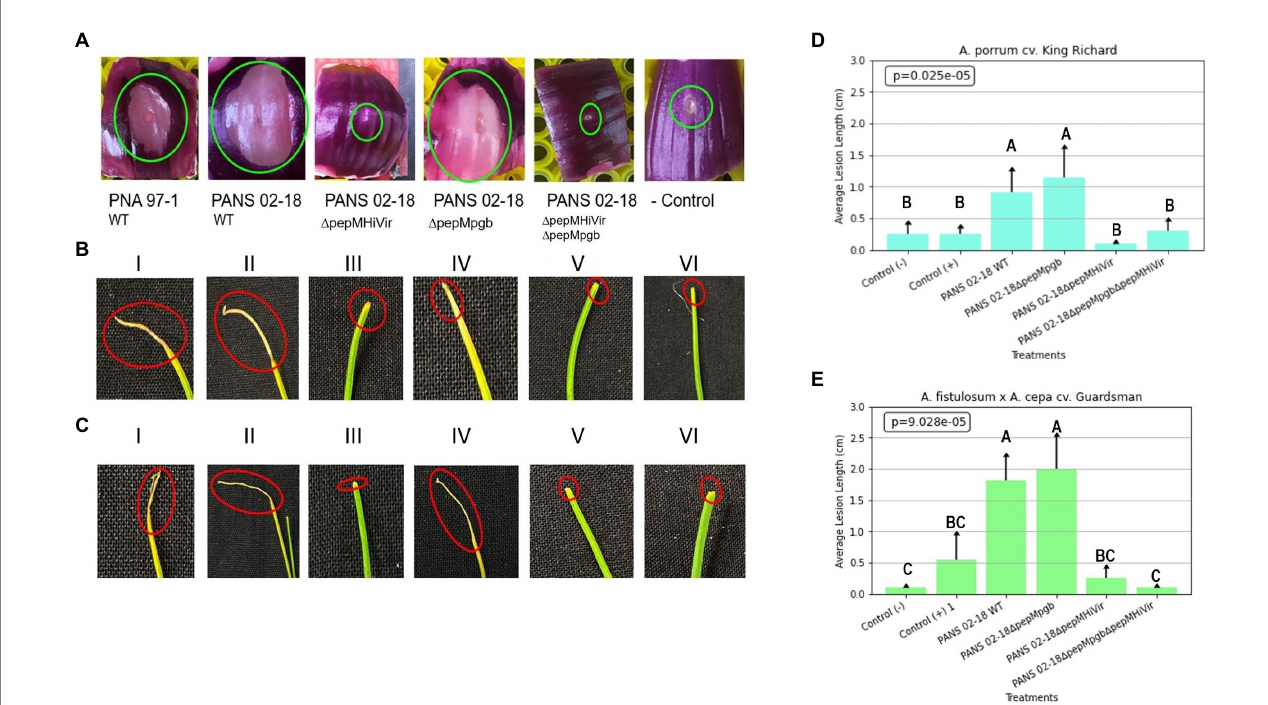
FIGURE 9 Role of HiVir and pgb biosynthetic clusters in foliar pathogenicity of Pantoea ananatis on Allium species. Panel (A) : Red scale necrosis phenotype observed with the wild-type and mutant strains of P. ananatis ; panel (B) : Foliar pathogenicity assay on leek ( Allium porrum cv. King Richard) seedlings with the wild- type and mutant strains of P. ananatis ; and (C) Foliar pathogenicity assay on Japanese bunching onion ( A. fistulosum × A. cepa cv. Guardsman) seedlings with the wild-type and mutant strains of P. ananatis . Green and red circles indicate red scale necrosis and foliar necrosis, respectively. Panels (D) and (E) display the results of the mean lesion length with standard error in A. porrum and A. fistulosum × A. cepa upon inoculation with the wild-type and mutant strains of P. ananatis . The strains utilized in the experiments mentioned above include positive control strain PNA 97-1, positive control PANS 99-11 (a known